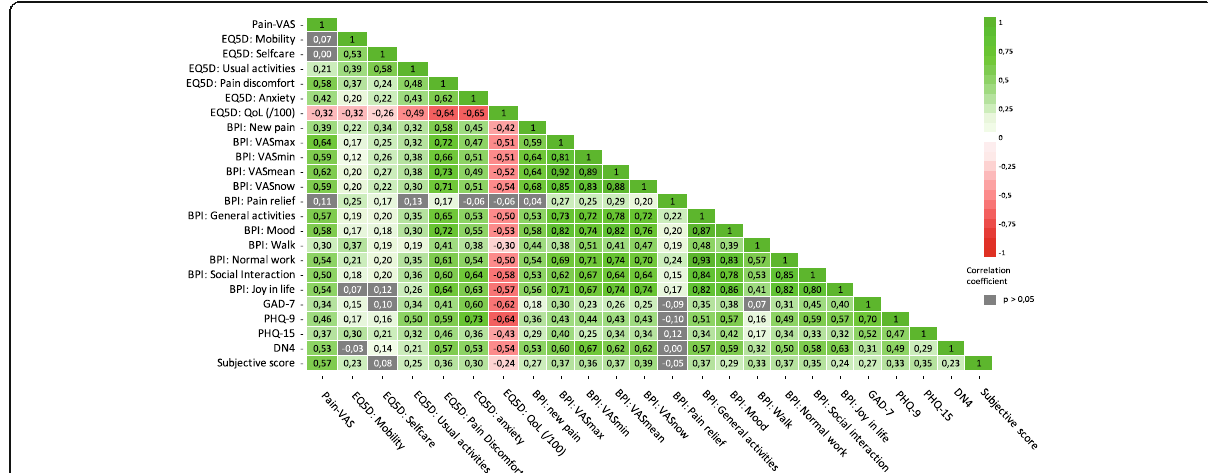
Fig. 3 Correlation between subjective neurosensory measurements. Correlation coefficients for significant positive correlations ( P < 0.05) are shown in green. Correlation coefficients for significant negative correlations ( P < 0.05) are shown in red. Non-significant correlations ( P > 0.05) are displayed in grey. The questionnaires were the pain visual analogue score (VAS) score, the EuroQol five-dimension scale (EQ5D-5 L), Brief Pain Inventory (BPI), General Anxiety Disorder 7 (GAD-7), Patient Health Questionnaire 9 and 15 (PHQ-9 and PHQ-15), Douleur Neuropathique 4 (DN4), and subjective functioning. This figure shows that most of the questionnaires were statistically significantly correlated with each other e.g. Pain- VAS correlated significantly with GAD-7, PHQ-9, PHQ-15, DN4, subjective score, and quality of life (EQ5D:QoL). Also, Quality of life showed a significant negative correlation (in red) with most questionnaire scores. GAD-7 and PHQ-9 showed the strongest negative correlation with quality of life